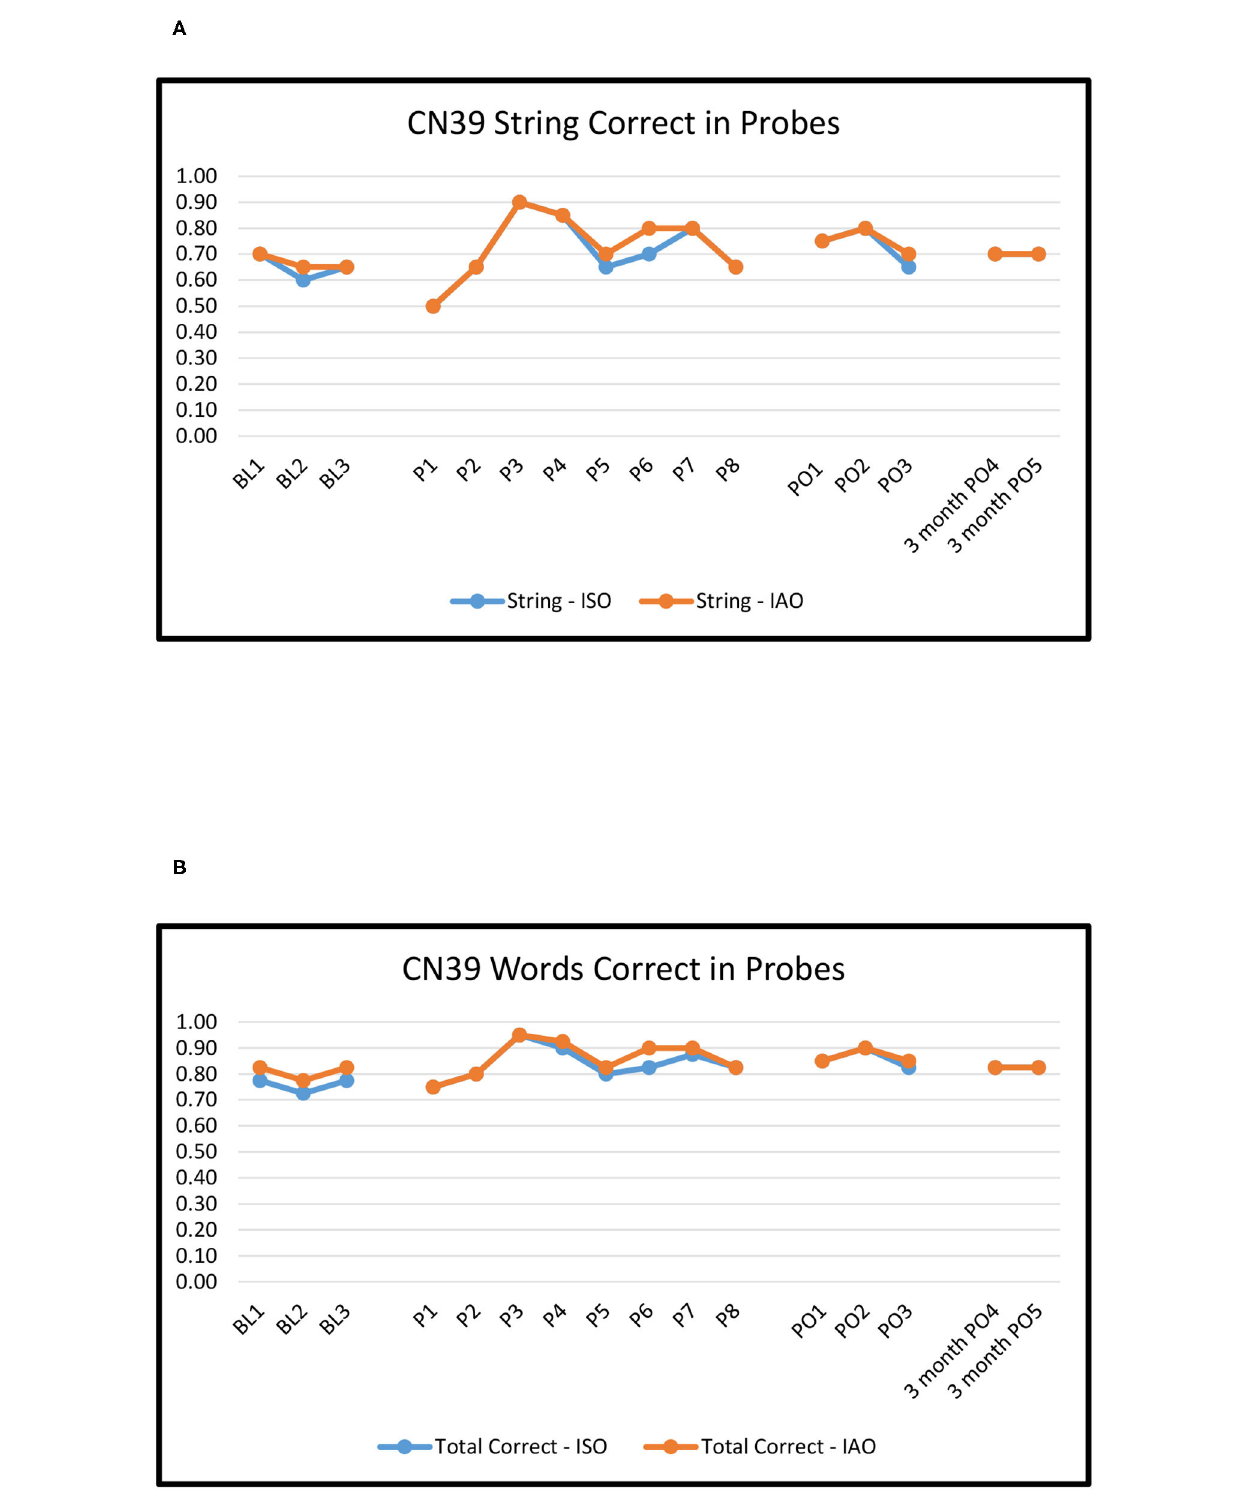
FIGURE 2 | CN39: Proportion of word strings (A) and words (B) correct in baseline, treatment, post-treatment, and 3 months follow-up probes.